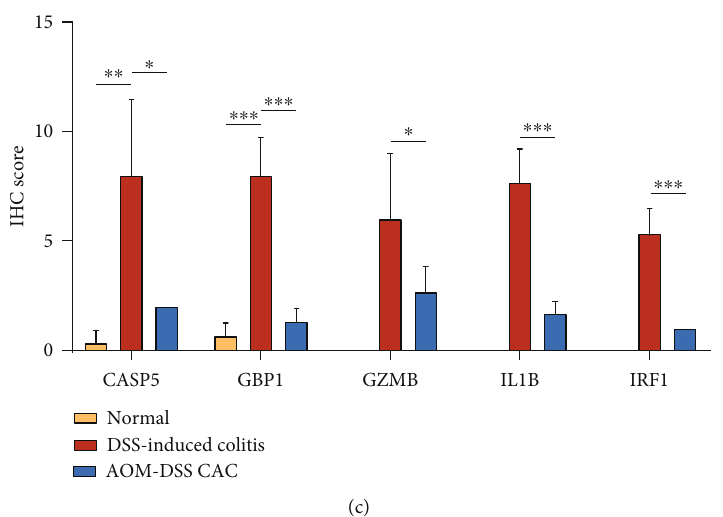
Figure 8: Validation of the levels of the PR-signature genes in vitro and in vivo. (a) The expressions of 5 PR-signature genes in normal NCM460 cells and TNF- α -stimulated in fl ammation cells. (b) Representative IHC images showing the expressions of 5 PR-signature genes in normal (left), DSS-induced colitis (middle), and AOM/DSS-induced CAC (right) tissues of mice. (c) Semiquanti fi cation of IHC staining of 5 PR-signature genes in normal, DSS-induced colitis, and AOM/DSS-induced CAC tissues of mice. CAC: colitis-associated colorectal cancer; IHC: immunohistochemistry. ∗ P < : 05 , ∗∗ P < : 01 , and ∗∗∗ P < : 001